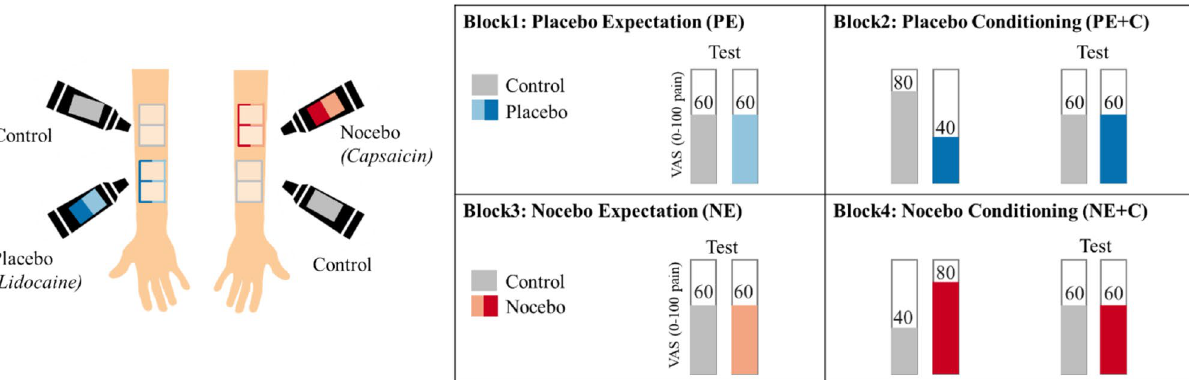
Figure 4. Placebo and nocebo paradigm. ( A ) Ointments and marked skin areas. For experimental block 1 and 2, a placebo ointment (“Lidocaine”) and a control ointment were introduced. It was explained that “Lidocaine” would exert an analgesic effect. Four skin areas were marked on one forearm of the participants. The skin areas were color-coded for “Lidocaine” and control treatment. For experimental block 1 and the conditioning part of experimental block 2, one control area and one placebo area were used, whereas the second phase (“test”) in experimental block 2 was performed on the remaining two skin areas on the same forearm. For experimental block 3 and 4, the nocebo ointment (“Capsaicin”) was introduced to the participants, as a treatment with a hyperalgesic effect. Four skin areas were marked on the other forearm. For experimental block 3 and the conditioning part experimental block 4, one control area and one nocebo area were used. Afterwards, the second phase (“test”) of experimental block 4 was performed at another nocebo area and control area. The order of the left and right arm and the position of placebo, nocebo and control were counterbalanced across participants. ( B ) Placebo and nocebo paradigm. In experimental block 1, placebo expectation (PE) effects were tested: Participants were exposed to two times eight heat stimuli, which were calibrated to match 60 on a 0 to 100 VAS ( VAS60 ). In experimental block 2, placebo conditioning (PC) effects were tested. Therefore, participants were first conditioned ( VAS80 stimuli for control skin area and VAS40 for placebo skin area) on the previous skin areas, and then tested again with VAS60 on the remaining two skin areas. Afterwards participants were introduced to the nocebo treatment and experimental block 3 and 4 were performed in the same manner as experimental block 1 and 2, except that the nocebo skin area was conditioned with VAS80 and the control skin area was conditioned with VAS40 , respectively. The overall order of the blocks was fixed for all participants, while the order of treatment (placebo or nocebo) and control was counterbalanced across